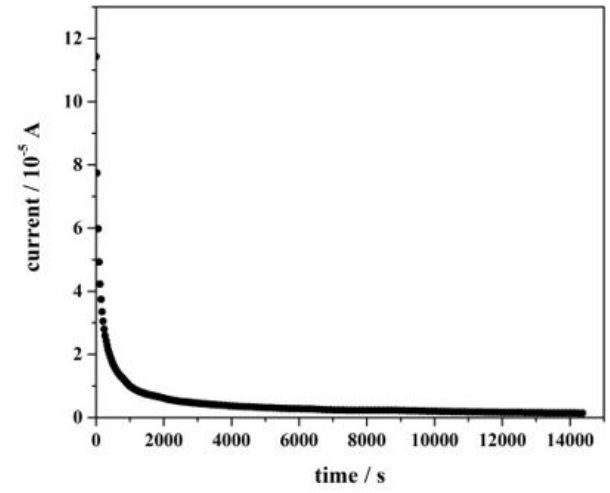
Figure 2: Current variation with time for the configuration SS/GPE/SS under 1V DC potential.